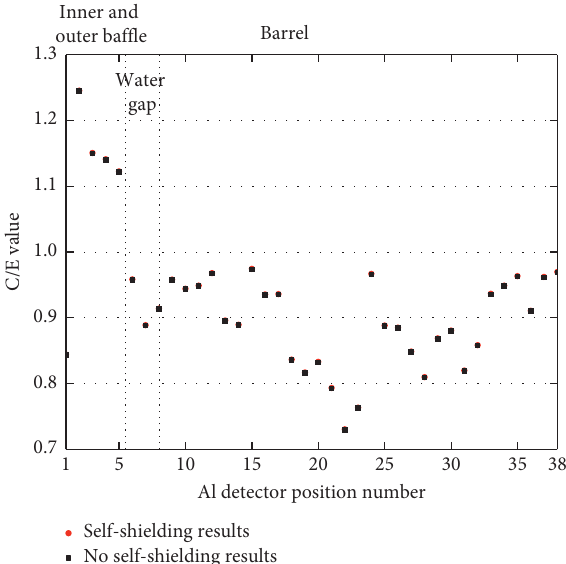
Figure 11: Comparison of self-shielding correction of the 58 Ni(n,p) 58 Co detector.